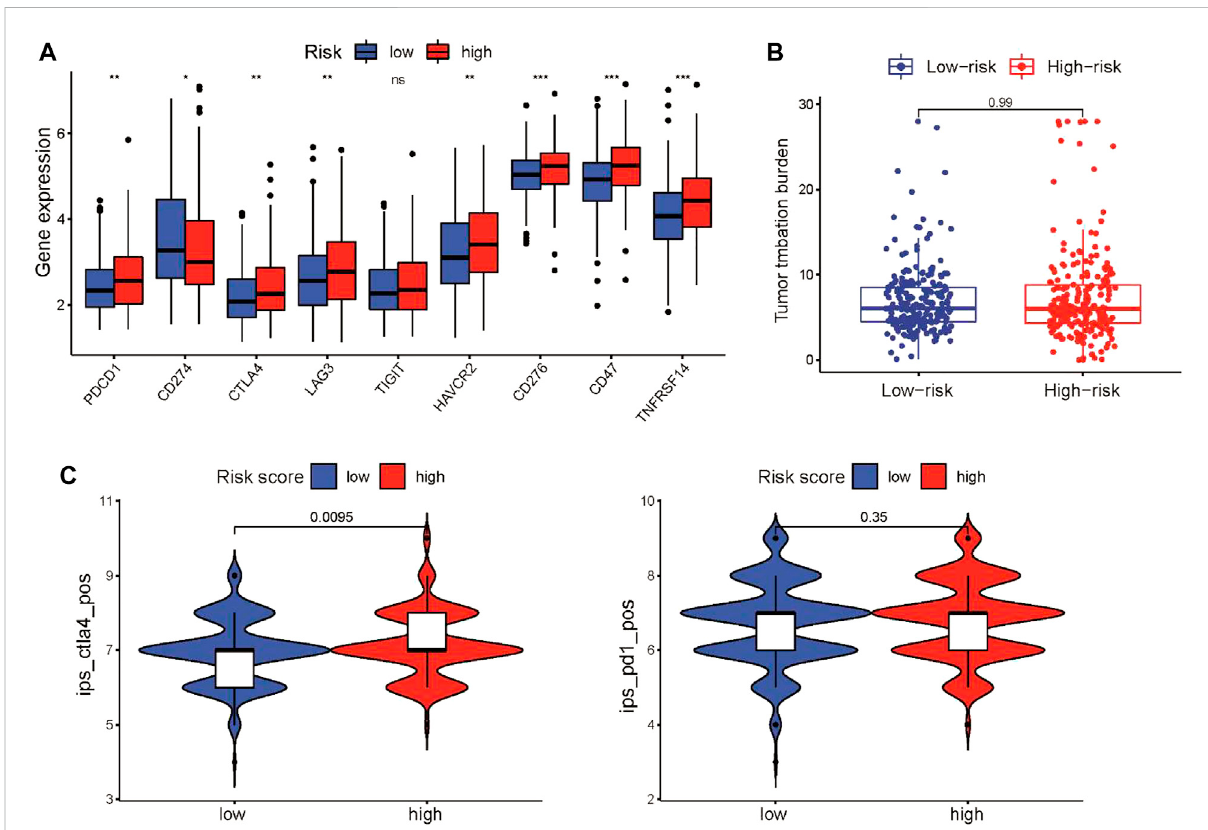
FIGURE 8 Characteristics of immune in fi ltrating cells in the high-risk and low-risk groups. (A) Box plots showing the relationship between the risk score and the expression level of coinhibitory immune checkpoint genes in the TCGA cohort. (B) TMB did not differ between the high-risk and low-risk groups. (C) Violin diagram showing the IPSs for CTLA-4 and PD-1 inhibitors for the two groups. * p < 0.05, ** p < 0.01, and *** p <